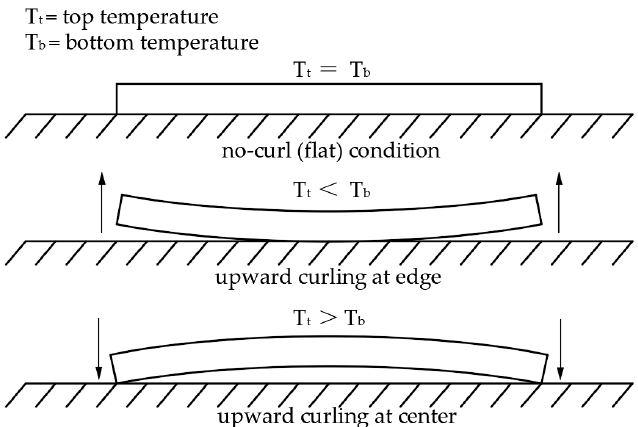
Figure 5. Temperature gradient frequency distribution of RCP.